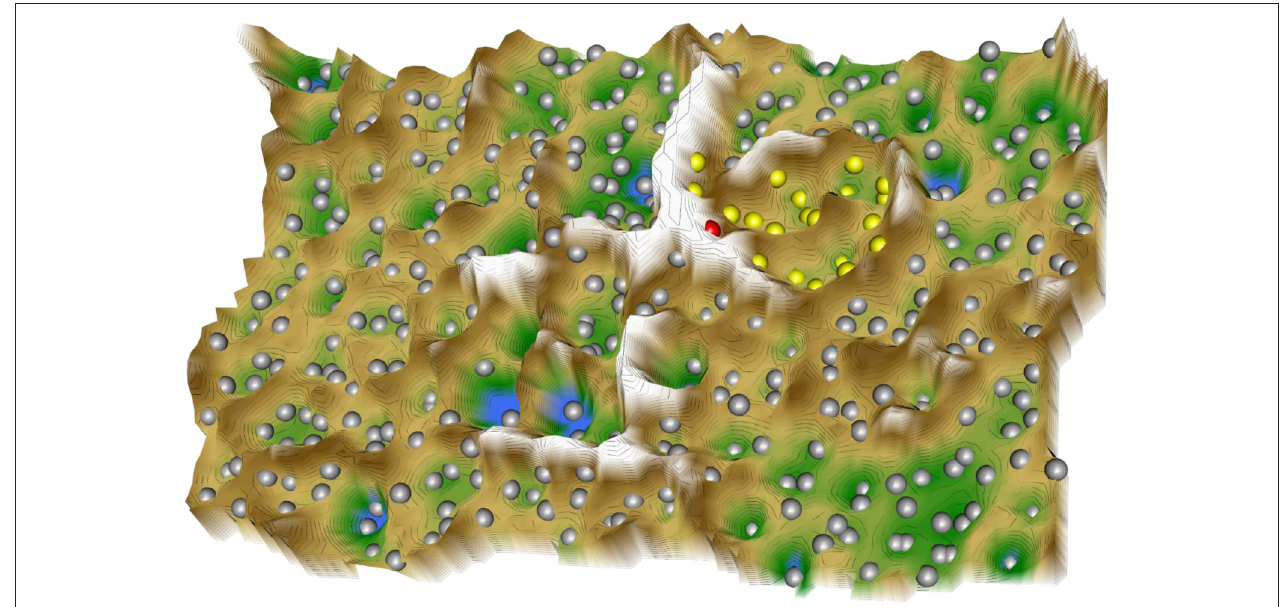
FIGURE 2 | 3D-view of the U-matrix visualization of distance based structures of the 414 × 38 sized “drug vs. biological process” matrix, comprising the 413 drugs annotated with one or more of the n = 38 biological processes assigned to both, the set of 20 genes causally implicated in insensitivity to pain and the drug targets queried form the DrugBank database, which following ABC analysis based item selection were found in at closer Euclidian distances form the virtual “PainInsensitivity” drug (red dot) that carried all of the n = 38 processes. The U-matrix has been obtained using a projection of the data points onto a toroid grid of 4,000 neurons where opposite edges are connected. The U-Matrix was colored as a geographical map with brown (up to snow-covered) heights and green valleys with blue lakes. Valleys indicate clusters and watersheds indicate borderlines between different clusters. The dots indicate the so-called “best matching units” (BMUs) of the self-organizing map (SOM), which are those neurons whose weight vector is most similar to the input. A single neuron can be the BMU for more than one data point; hence, the number of BMUs may not be equal to the number of drugs. In the vicinity of the red dot, i.e., the virtual “PainInsensitivity” drug, a mount ridge surrounded valley was observed that represented a cluster of drugs (yellow dots) most similar to the virtual “PainInsensitivity” drug. However, the latter was located eccentrically in the cluster indicating that the similarity to any of the DrugBank queried repurposing candidates for pain therapy is incomplete. The other drugs (gray dots) lay outside the cluster of the “PainInsensitivity” drug and could therefore be rejected as repurposing candidates based on the present approach to search for drugs that with respect to the addressed biological processes are most similar to the pattern of biological processes in which the genes associated with insensitivity to pain are involved. The figure has been created using the R software package (version 3.3.3 for Linux; http://CRAN.R-project.org/; R Development Core Team, 2008) using our R library “Umatrix” (M. Thrun, F. Lerch, Marburg, Germany, http://www.uni-marburg.de/fb12/datenbionik/software; file